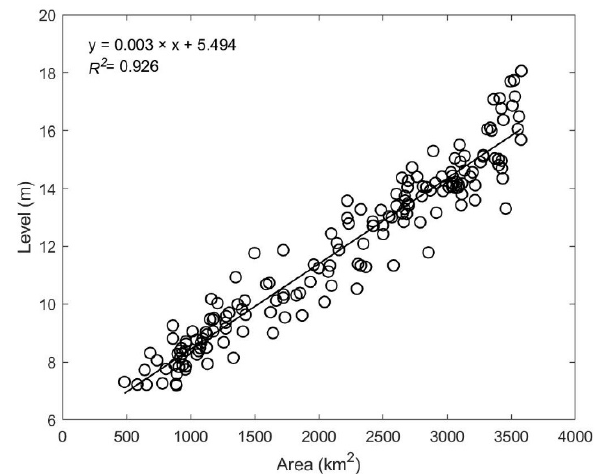
Figure 3. The relationship between the area and water level of Poyang Lake during 2000–2020.